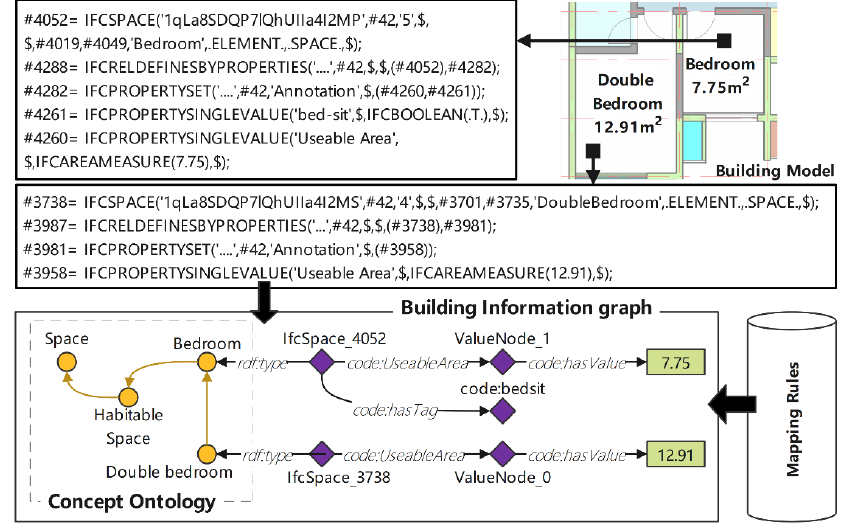
Figure 22. Mapping results of the designed building model (partly).